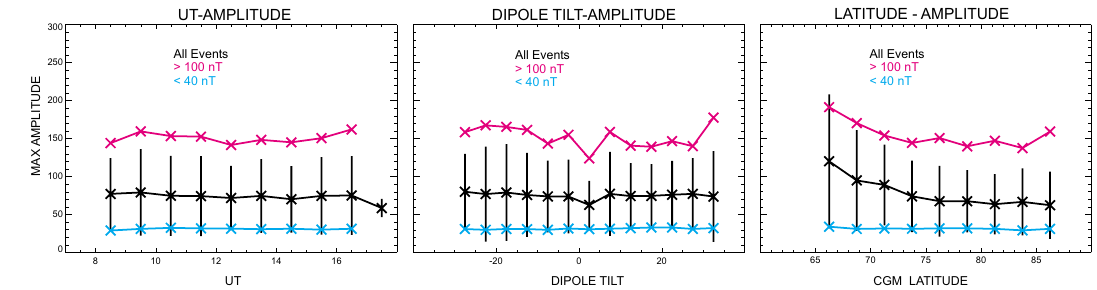
Fig. 11. Mean amplitude of events are shown as functions of UT-time of events (left panel), dipole tilt-angle (middle panel), and event latitude (right panel). In all panels, black crosses and error-bars (standard deviation) present the results for the full set of events; magenta crosses are for the subgroup of large amplitude events, and cyan crosses are for the small amplitude events.